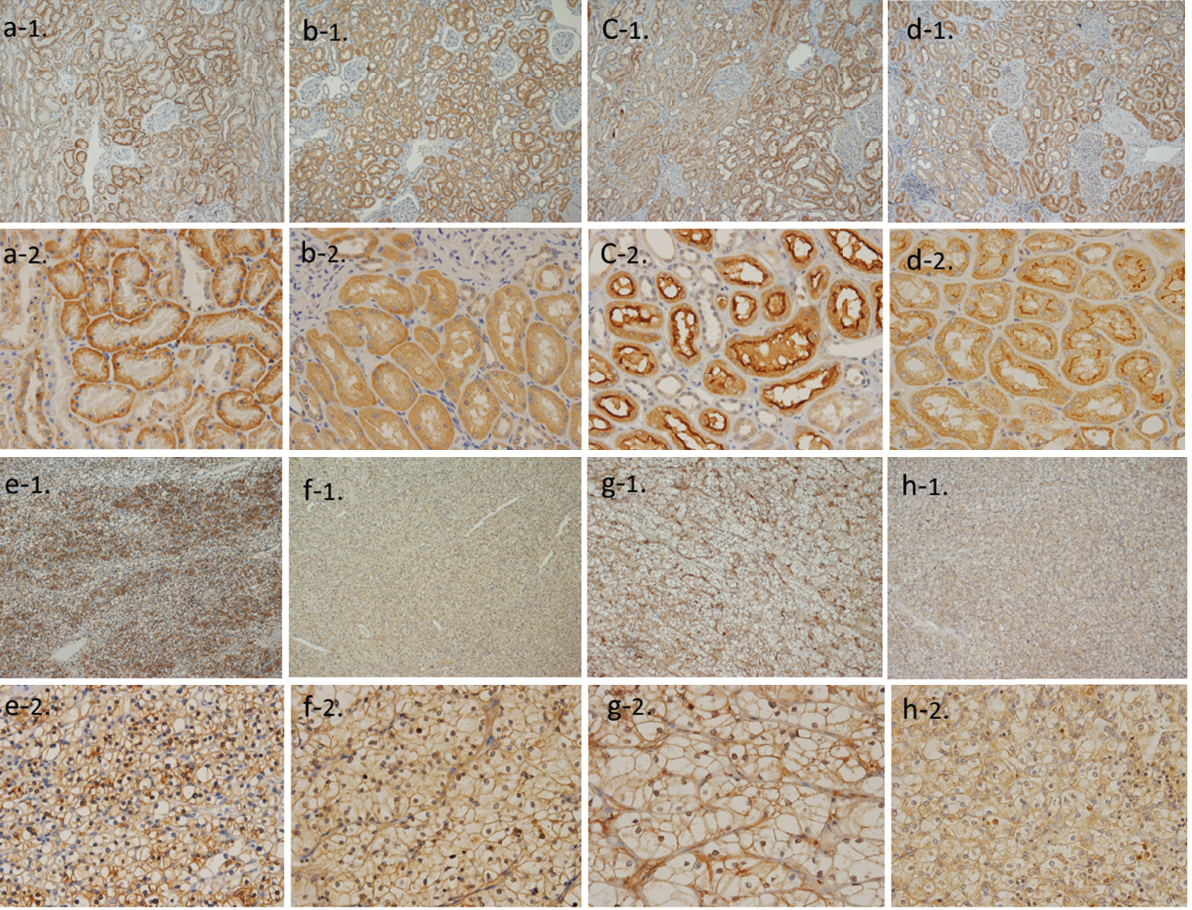
Figure 1 - Immunohistochemical staining of paired normal and Rcc tissues for GLUT - 1 (a-1, 2, e-1, 2), GLUT - 2 (b-1,